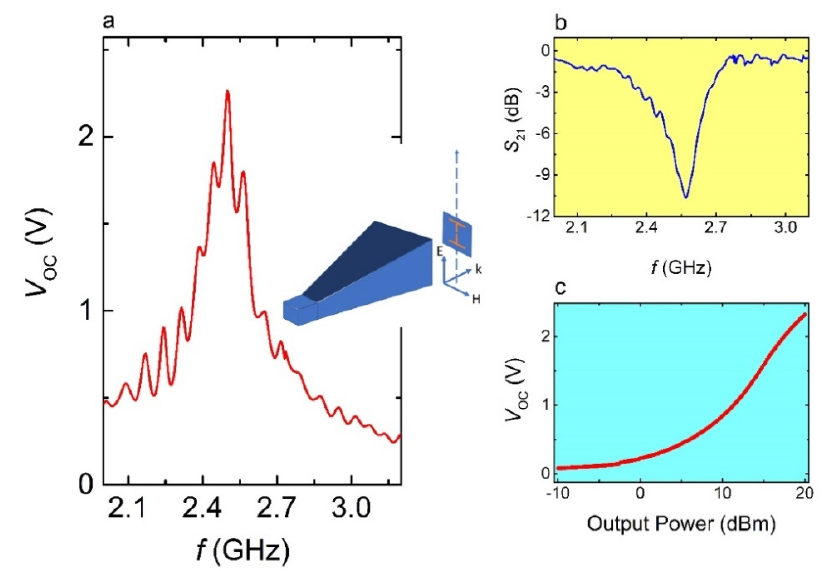
Figure 6. ( a ) Open circuit voltage V OC vs. f, for the Ag/PLA MS unit. The experimental configuration is shown in the sketch; ( b ) EMI response of the MS unit, with diode attached to the MS gap; ( c ) V OC as a function of the horn output power.